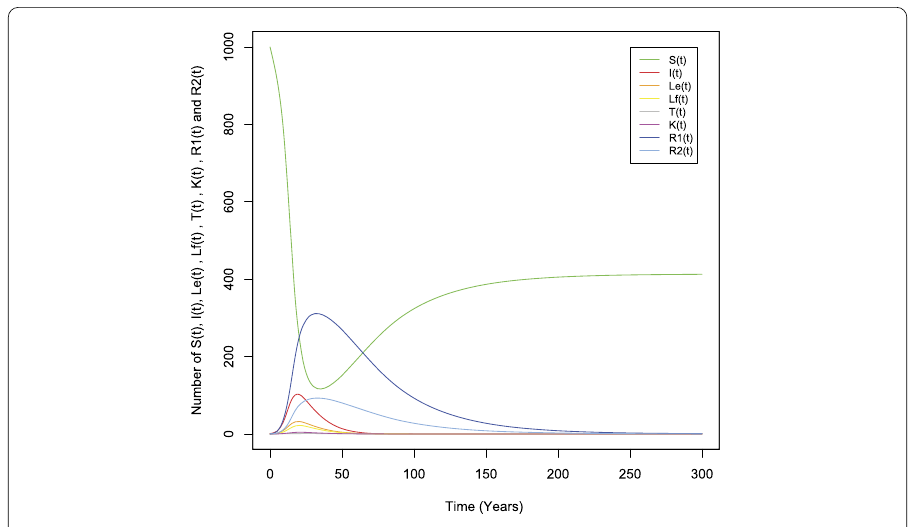
Figure 3 Evolution of the model for several years and disease-free equilibrium stability of the model system (1) with R